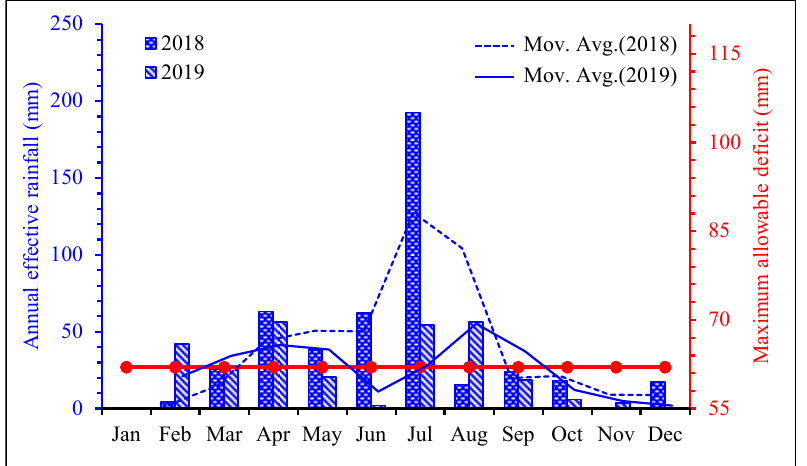
Figure 8. Annual effective rainfall distribution pattern in 2018 and 2019 with maximum allowable deficit (MAD).